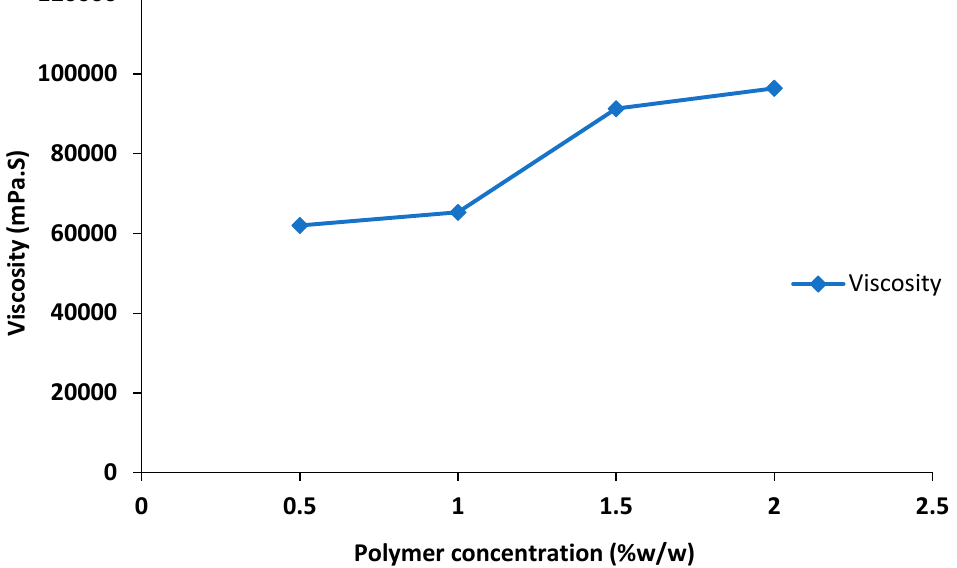
Figure 3. Effect of polymer concentration on viscosity of nanoemulgel.